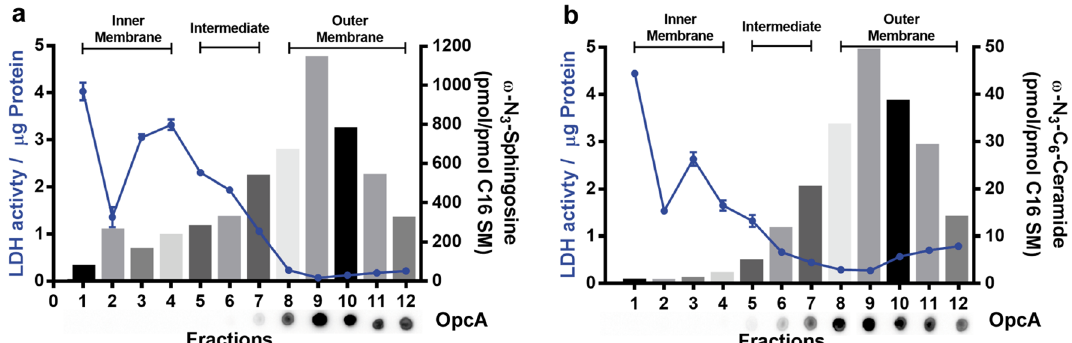
Figure 5. Quantification of azido-functionalized sphingolipid levels in membrane fractions of N. meningitidis by mass spectrometry. Characterization of membrane fractions (1–12) of N. meningitidis after treatment of bacteria with either ω-N 3 -sphingosine ( a ) or ω-N 3 -C 6 -ceramide ( b ). Each fraction was tested for LDH activity per µg protein (blue line), as inner membrane marker and OpcA abundance by dot blot (below X-axis) as outer membrane marker. Bars represent the amount of azido-functionalized sphingosine or ceramide, as determined by HPLC–MS/MS, normalized to the amount of C16 sphingomyelin (SM) found in the samples. LDH data show the mean ± SD of a representative experiment performed in